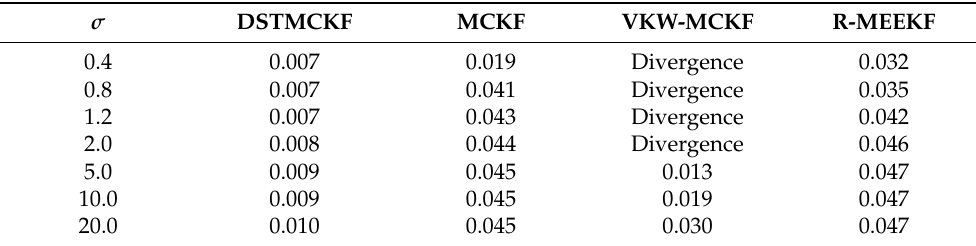
Table 3. RMSE (m) with different σ (Case